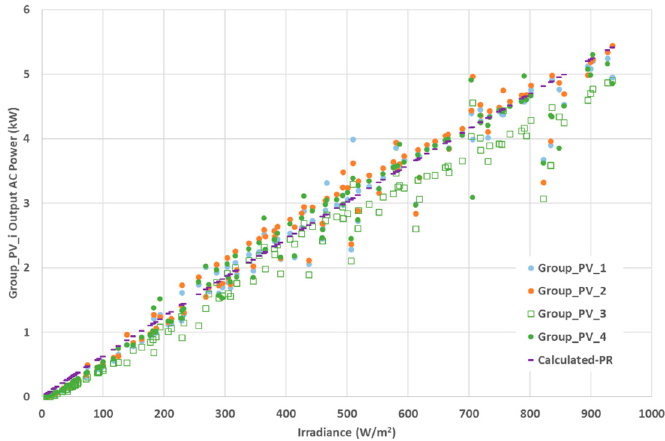
Figure 7. Calculation of the expected AC output power of a group of inverters in the CdTe PV parking garage system (purple bars) as a function of measured irradiance for a whole day. Experimental output values of different strings are also presented (circles), one of them clearly underperforming (Group 4, open green squares).